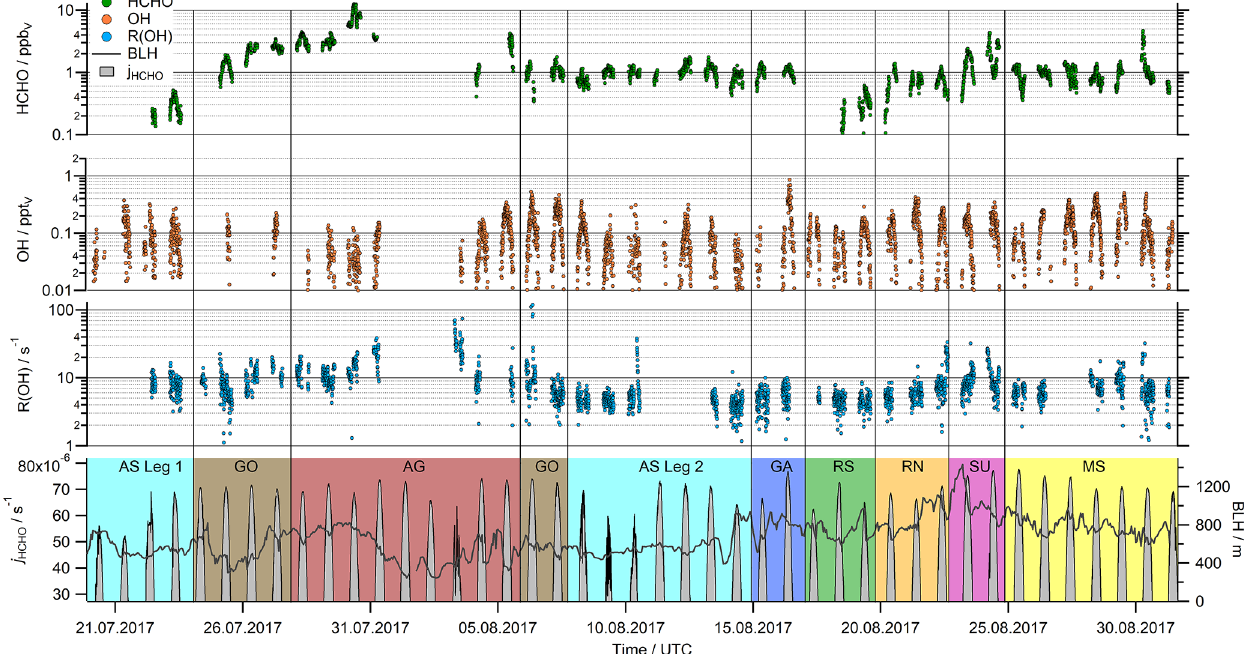
Figure 2. Time series of HCHO, OH, R ( OH ) and the HCHO photolysis ( j HCHO , sum of the molecular and the radical channel) in 5min resolution. For the boundary layer height (BLH), we used the ERA-5 meteorological reanalysis data in hourly averages, which resolve the earth’s atmosphere on a 30km grid (https://www.ecmwf.int/en/forecasts/datasets/reanalysis-datasets/era5, last access: 3 December 2020).